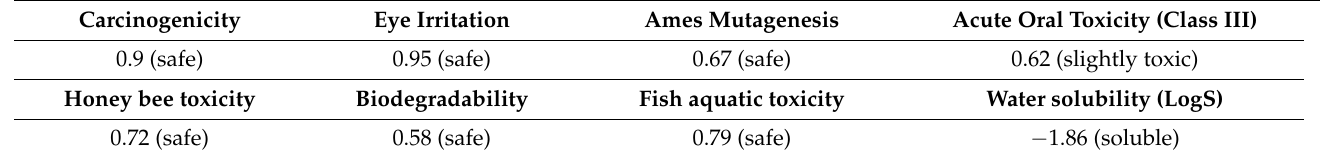
Table 6. Eco-toxic properties of Q-22 inhibitor [34,35].